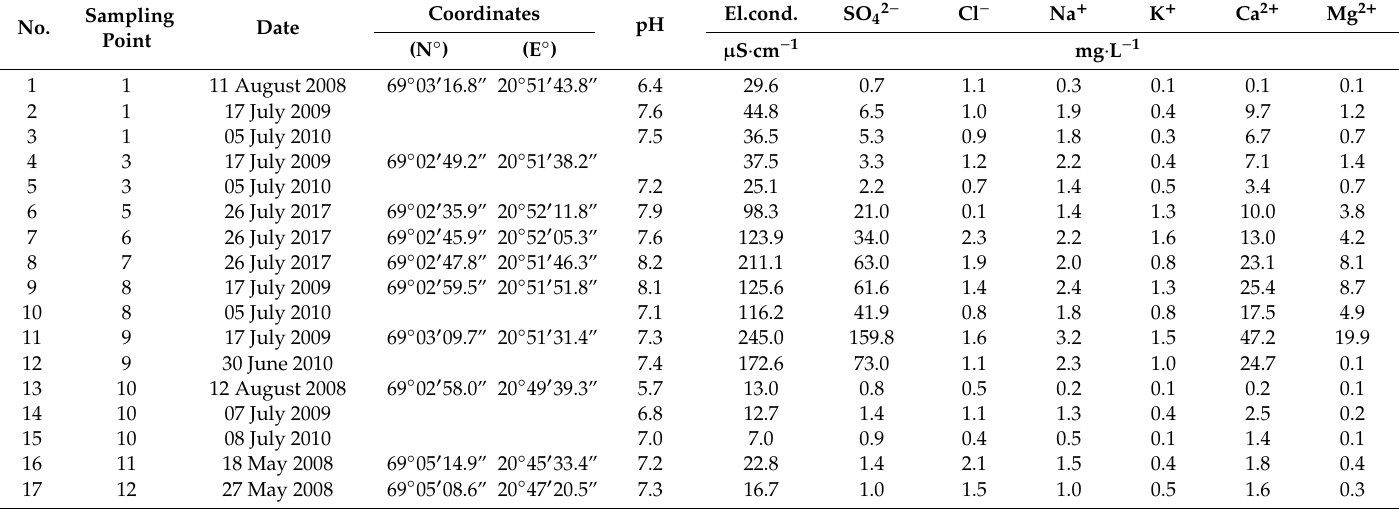
Table 3. Chemical composition of streams in the Kilpisjärvi area in 2008, 2009, 2010 and